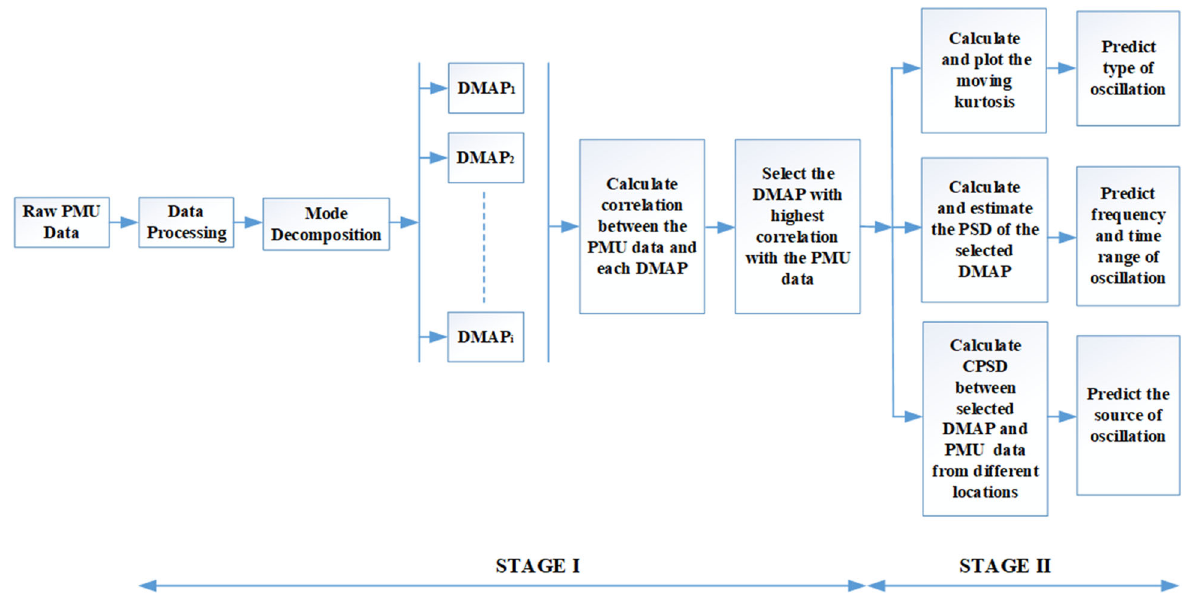
Fig. 2 Flow chart of the proposed